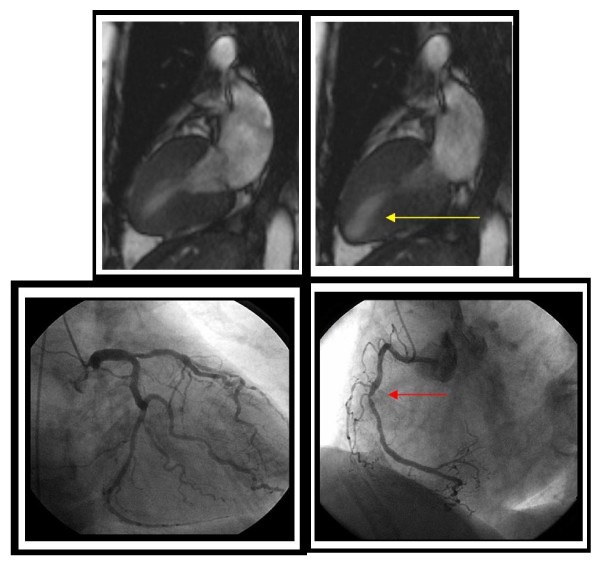
Inducible left ventricular wall motion abnormalities indicative of ischemia. A resting end-systolic frame from a 2-chamber view is shown in the top left corner demonstrating normal left ventricular contraction with no wall motion abnormalities. The top right image shows a peak dobutamine end-systolic cine view; the yellow arrow highlights hypokinesis of the inferoapical region. The bottom images are a caudal view of the right anterior oblique projection during contrast coronary angiography. The bottom left image exhibits a 70% proximal left anterior descending, 80% obtuse marginal, and 60% distal circumflex lesions. The red arrow in the bottom right highlights an 80% lesion in the mid-right coronary artery.